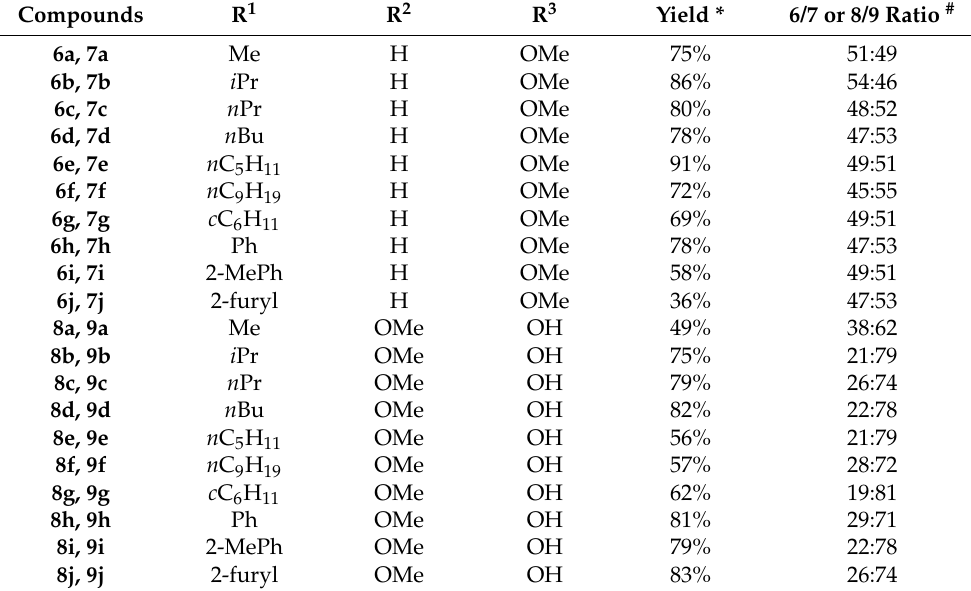
Table 1. Synthesis of o-amido-substituted 1,3-diarylpropene products 6a–j – 9a–j . Compounds